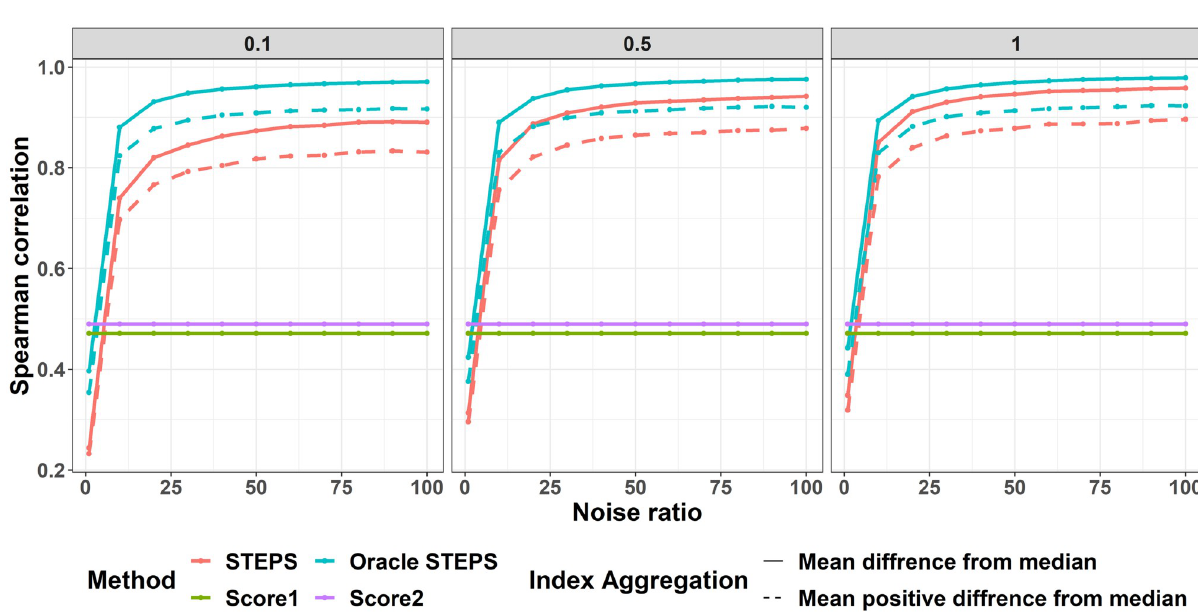
Fig 5. Correlations between all scores to the latent severity. X-axis is the noise ratio. Y-axis Spearman’s correlation coefficient. Color represents the different models and line type distinguishes between aggregation methods for the STEPS scores. Columns are different λ